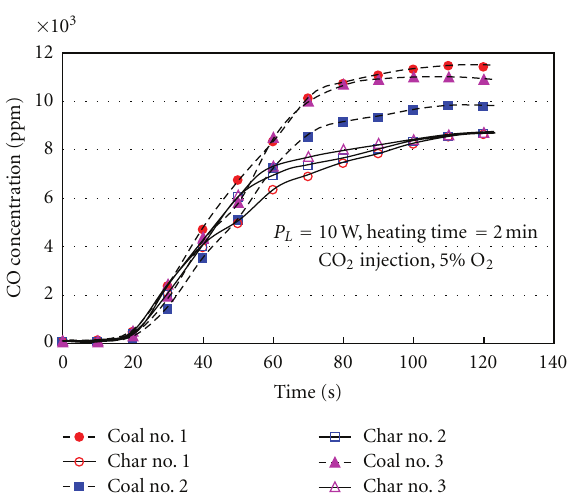
Figure 15: Comparison of the six kinds of samples tested for CO gas generation by CO 2 injection.